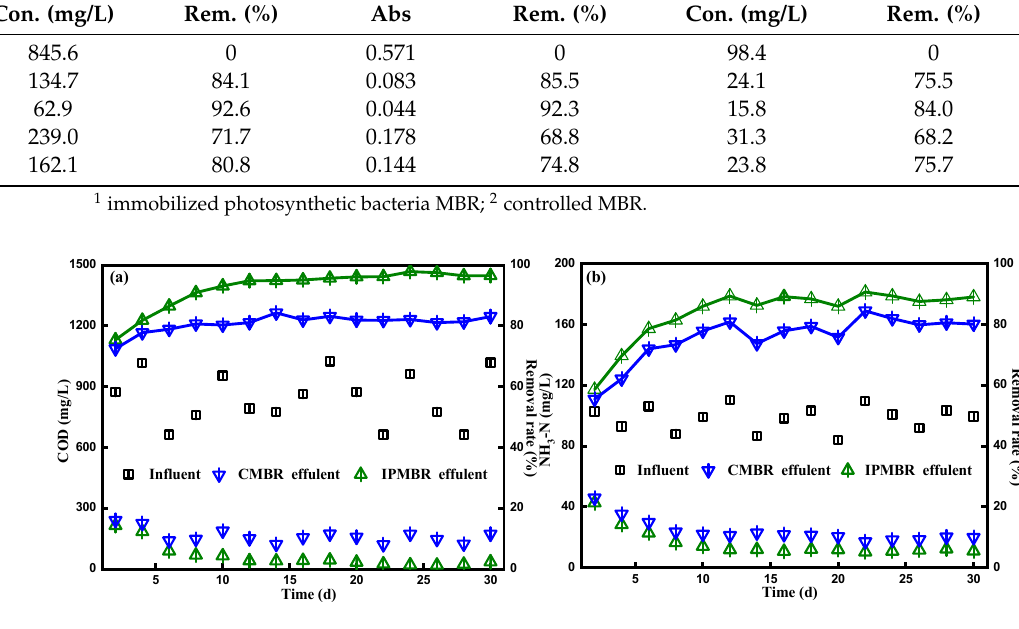
Figure 6. ( a ) Variation of the concentration of chemical oxygen demand (COD) and corresponding removal efficiency and ( b ) variation of the content and removal efficiency of NH 3 -N in different PSB–membrane bioreactors (MBRs) systems.